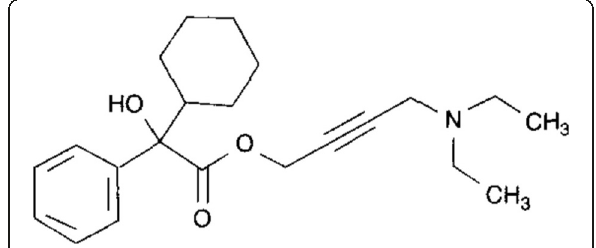
Fig. 14 Structure of oxybutynin